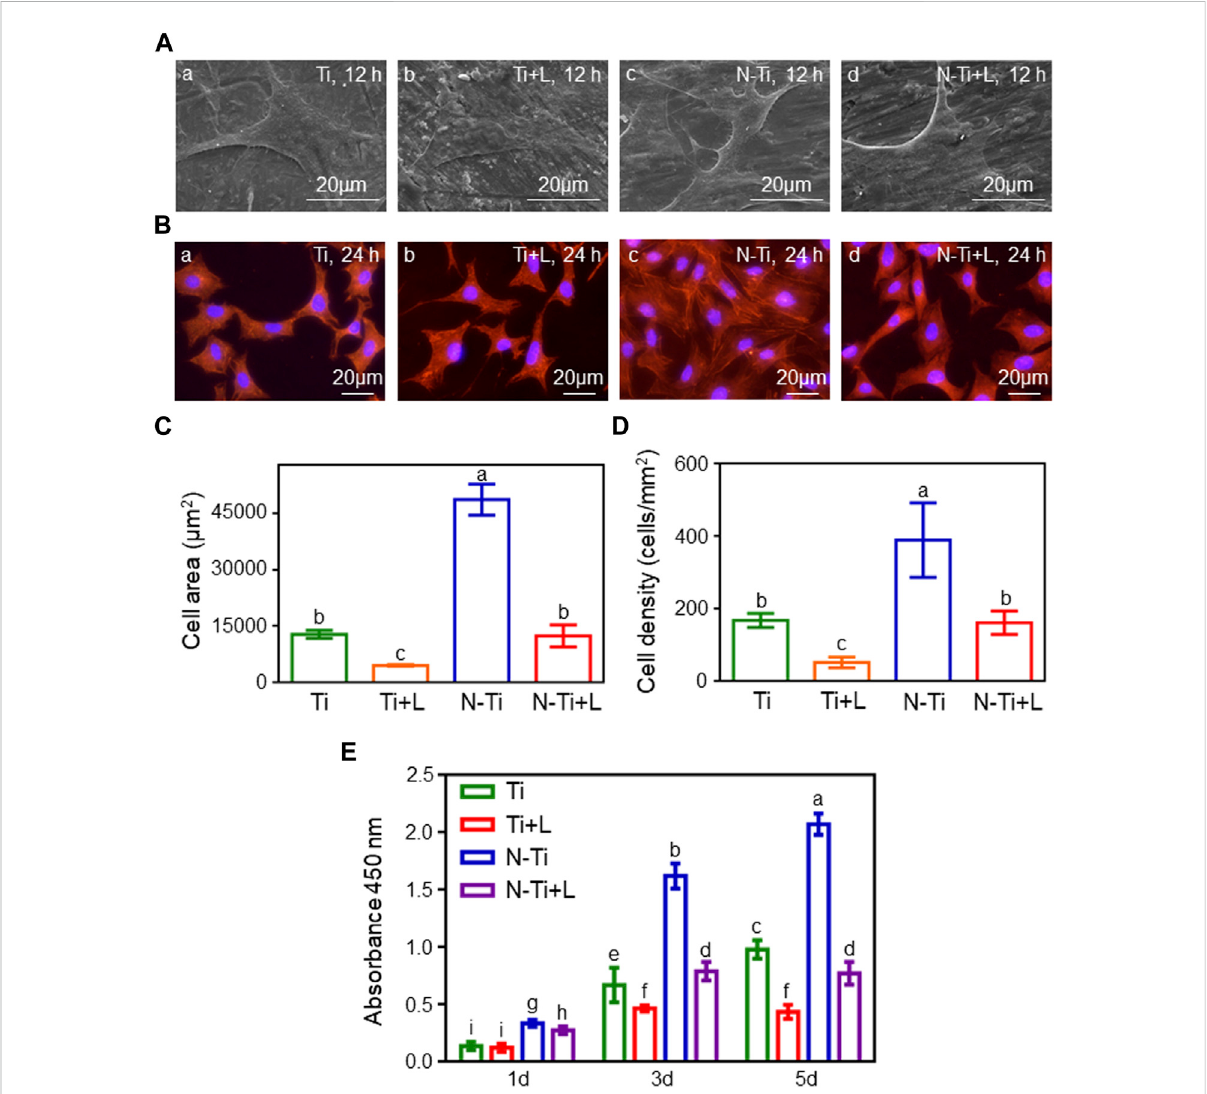
FIGURE 1 Cell morphology, adhesion and proliferation of MC3T3-E1 cells. (A) Cell morphology of MC3T3-E1 cells cultured on Ti, Ti + L, N-Ti, N-Ti + L surface after 12 h of incubation. (B) TRITC Phalloidin, and DAPI labeled MC3T3-E1 cells on Ti surfaces at 24 h. Area (C) and density (D) of MC3T3-E1 cells wereanalyzed quantitatively. (E) Cell proliferation ofMC3T3-E1cellson Tisamples surfaceafter 1d,3 dand 5 dofculture.Results areshownas mean ± SD; n = 6/group. Values with diverse letters are signi fi cantly different ( p <